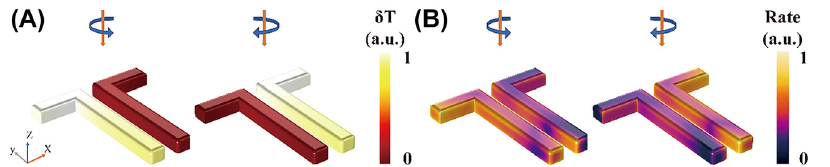
Figure 5: HE and thermal effects of the